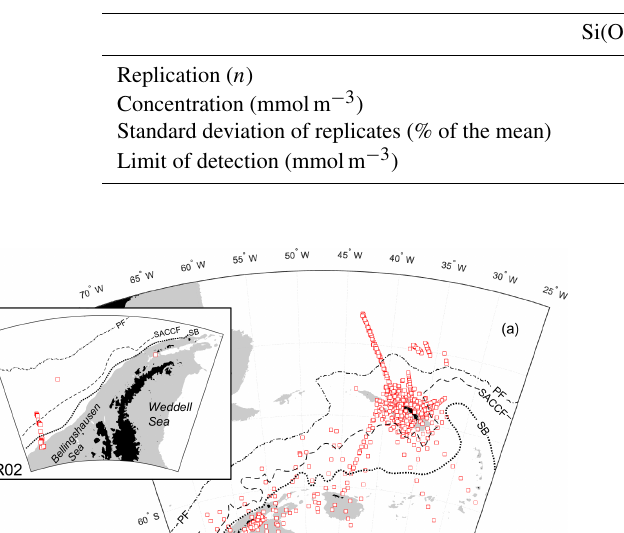
Table 2. Replication and limits of detection measured for chemistry methods (Whitehouse and Woodley, 1987).